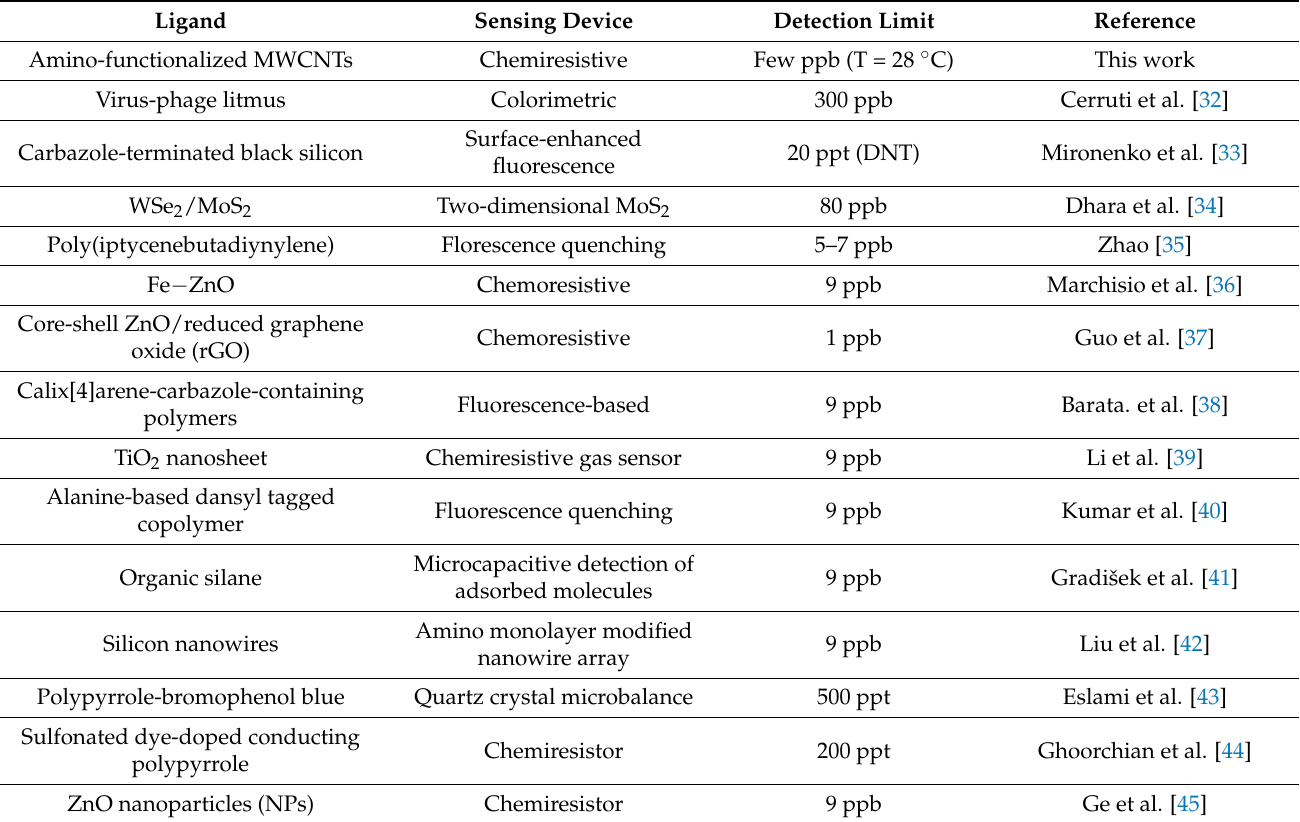
Table 2. Summary of the recent literature and techniques able to detect nitroaromatic explosives in the gas